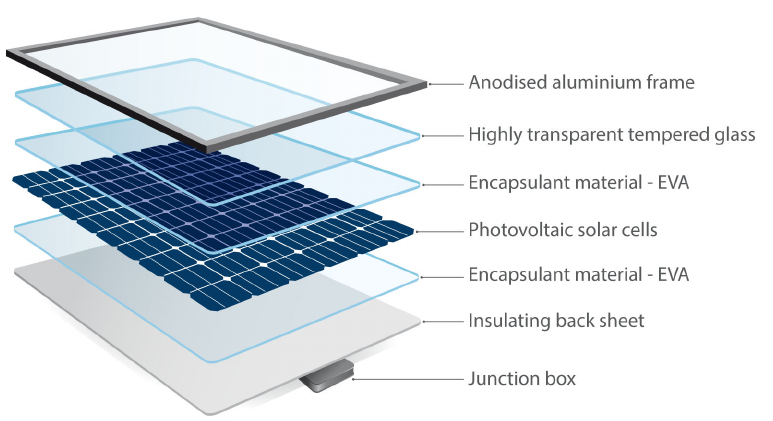
Figure 1. Structure of a photovoltaic module. Reproduced with permission from Global Sustainable Energy Solutions Pty Ltd. (GSES). Table 1. Material composition of a photovoltaic module [28].